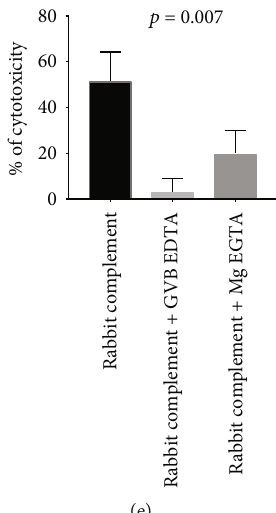
Figure 2: Anti-PLA2R1-mediated cytotoxicity depends on complement in immuno fl uorescence cytotoxicity assay. (a) Anti-PLA2R1- mediated cytotoxicity depending on complement for a PLA2R1-positive serum and a healthy donor serum. HEK T+: HEK293T-REx cells transfected with PLA2R1 and induced with tetracycline to overexpress PLA2R1. HEK T-: HEK293T-REx cells transfected with PLA2R1 but not induced with tetracycline. C+: addition of rabbit complement. C-: no addition of rabbit complement. Dead cells appear in red; living cells appear in green. (b) Anti-PLA2R1 complement-mediated cytotoxicity in a cohort of 48 patients and 20 healthy donors in di ff erent conditions. Note a low level of cytotoxicity in noninduced HEK that tended to be signi fi cant ( p = 0 : 08 ) caused by a minimal expression of PLA2R1 even in noninduced cells, as determined by western blot (c). All samples were tested using the same batch of HEK293 cells. A minimum of 50 cells per well was necessary for reading. (c) Expression of PLA2R1 in noninduced and induced HEK293 cells with tetracycline. Note a minimal expression of PLA2R1 in noninduced cells. (d) Analysis of complement activation pathways involved in anti-PLA2R1-mediated cytotoxicity for 3 PLA2R1-positive patients using two inhibitors of complement pathways. Patients 1 and 2 were positive for both IgG3 and IgG4 anti-PLA2R1 antibodies, while patient 3 was only positive for IgG4 anti-PLA2R1. An excess of GVB-EDTA (inhibitor of the three pathways of the complement) or Mg-EGTA (inhibitor of the classical and lectin pathways) was added in serum + complement and the complement-mediated cytotoxicity was measured. All samples were tested using the same batch of HEK293 cells. A minimum of 50 cells per well was necessary for reading. (e) Analysis of complement activation pathways involved in anti-PLA2R1-mediated cytotoxicity for 3 PLA2R1-positive patients. Note that GVB-EDTA strongly inhibits anti-PLA2R1-mediated cytotoxicity in all 3 patients, while Mg-EGTA, which is known to inhibit only the classical and lectin pathways, inhibits only partially the anti-PLA2R1-mediated cytotoxicity, suggesting a potential activation of the alternative pathway in some serum samples. A minimum of 50 cells per well was necessary for reading. HEK293 T-REx cells transfected with PLA2R1 and induced with tetracycline to express PLA2R1 were used. Negative controls (noninduced HEK T-REx cells) are not shown. All cytotoxicity assays were performed using the same batch of HEK293 T-Rex cells. A minimum of 50 cells per well was necessary for